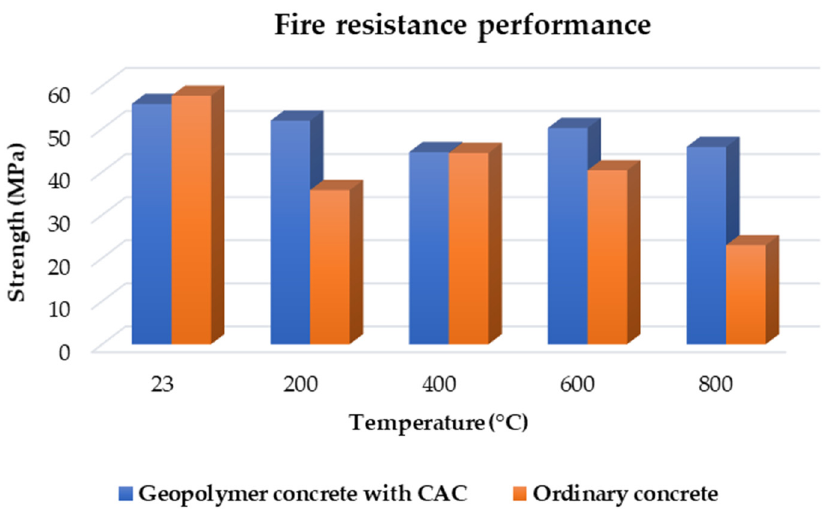
Figure 14. Comparative study on the fire resistance of geopolymer and ordinary concretes (adapted from [69]).